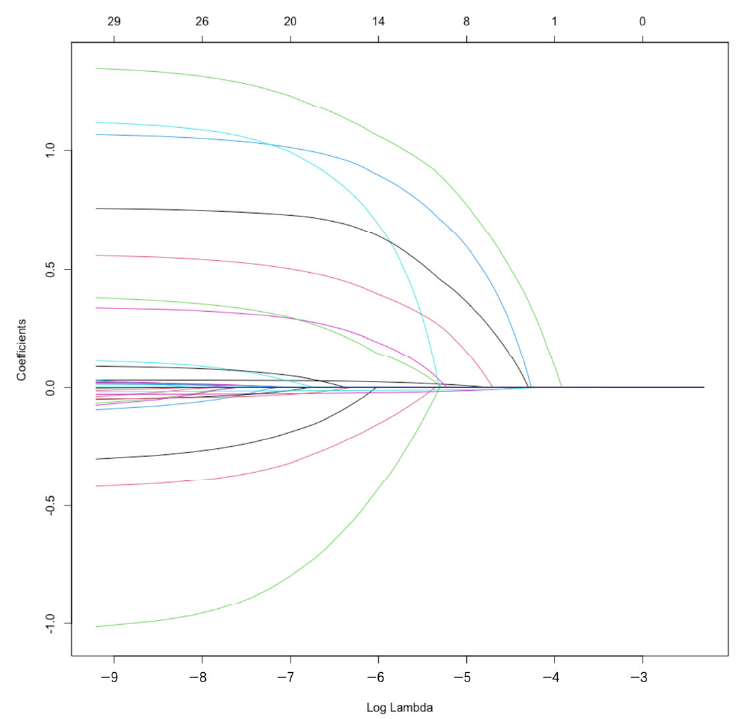
Figure 3. Log( λ ) and the LASSO regression coefficient. Table 3. Multivariable LASSO-logistic regression analysis of perioperative